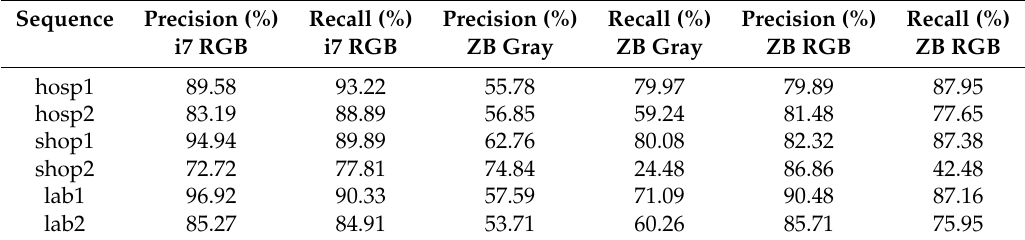
Table 9. Comparison of precision and recall for the tracking algorithm.